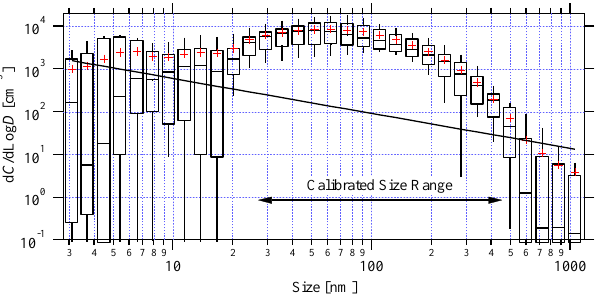
Figure 2. Percentiles of concentration by size bin. Error lines show 10 and 90%, boxes show 25 and 75%, and centre-line shows medians. Average values shown as ( + ) . Solid line shows the typical FMPS noise with filtered inlet air. Sizes in the calibrated range are shown. Outside this range, sizes are based on extrapolation of the calibrated best fit.